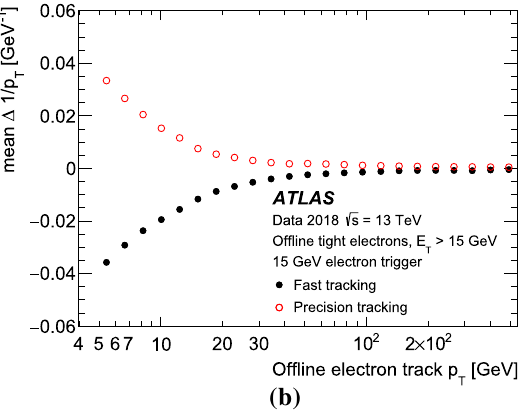
Fig. 31 The ID trigger residual in 1 / p T with respect to offline for the fast and precision tracking for electron candidates with the offline track transverse momentum the range in 7 . 4 < p T < 13 . 6GeV selected by